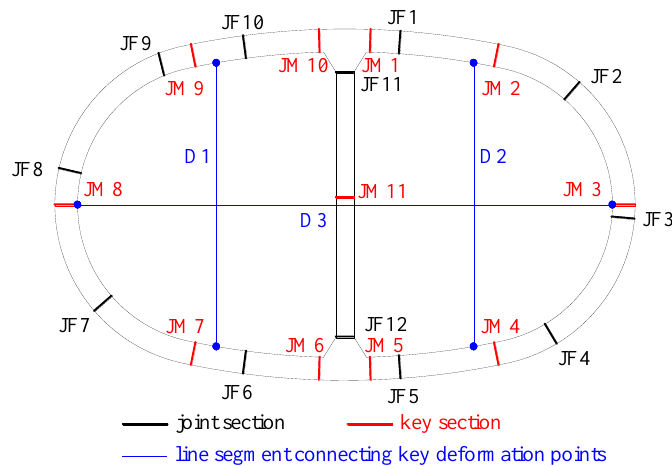
Figure 6. Key sections and deformation points for the model calculation.